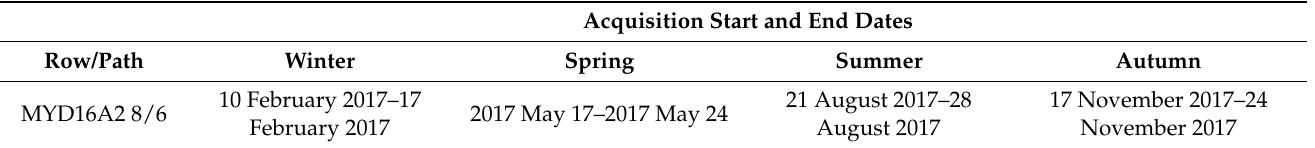
Table 3. Path/Row and acquisition dates of utilized images for Evapotranspiration of